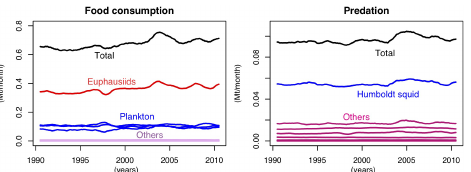
FIGURE A1 Monthly consumption by (left) and of (right) mesopelagic fi sh.